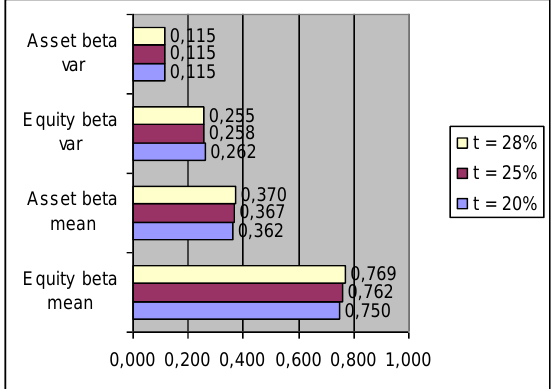
Chart 1: Comparing statistical results of three (3) scenarios of changing tax rate